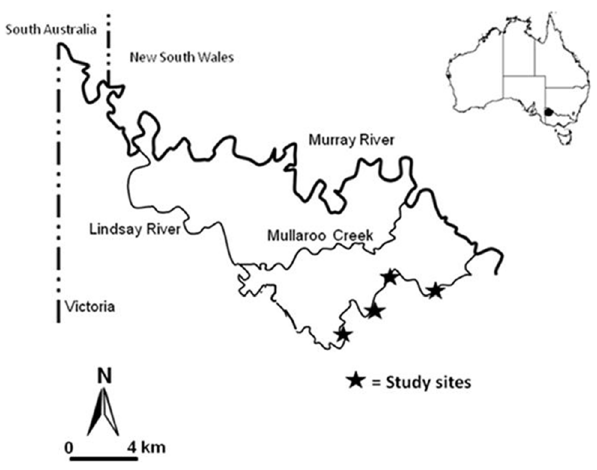
Figure 1. Map of the study area; Lindsay River, Victoria, Australia.